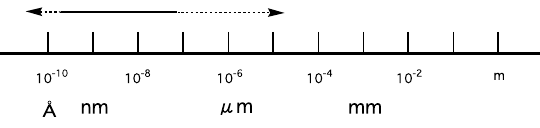
Fig. 1 . Domain size in hybrid